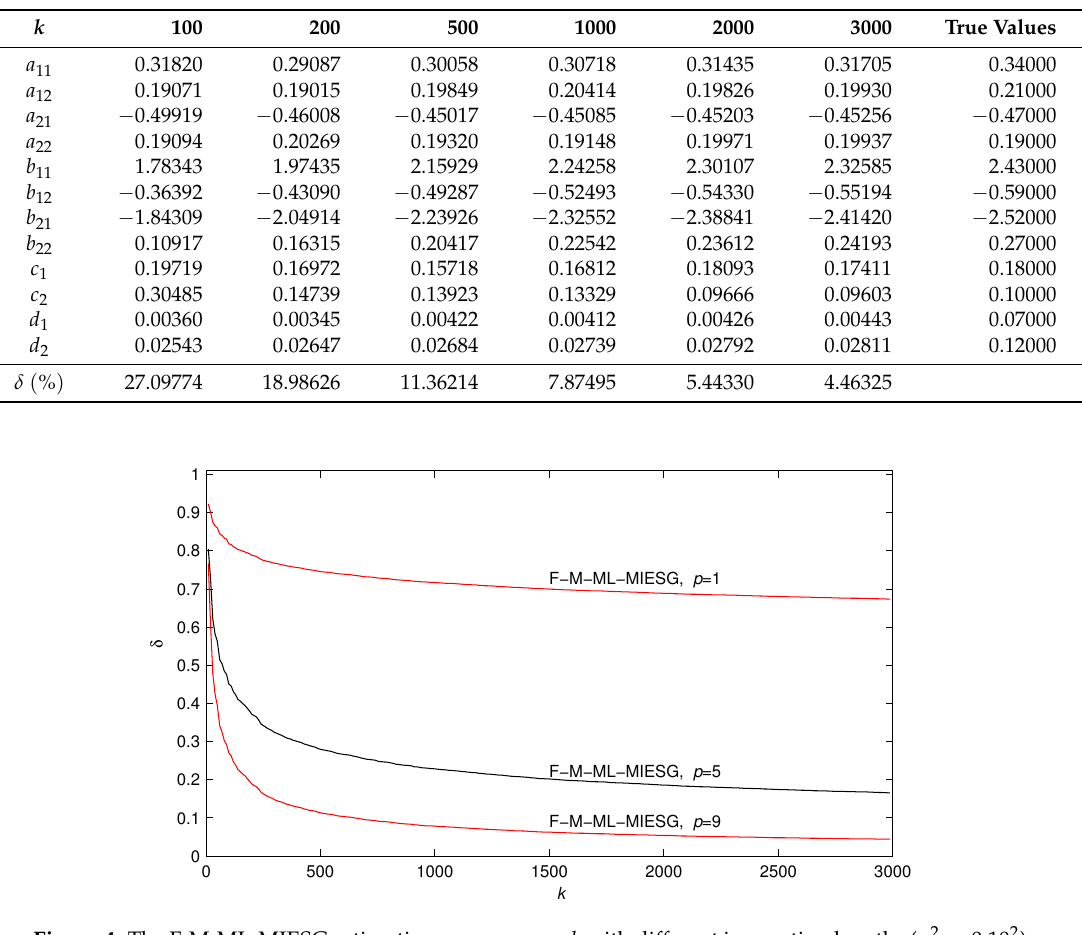
Figure 4. The F-M-ML-MIESG estimation errors versus k with different innovation lengths ( σ 2 = 0.10 2 ).